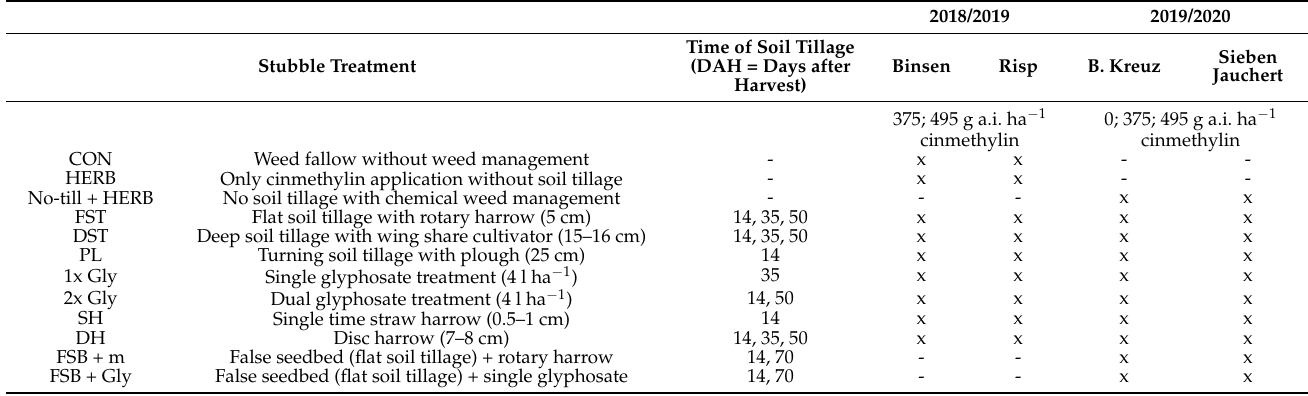
Table 3. Conducted stubble treatments and doses of herbicide